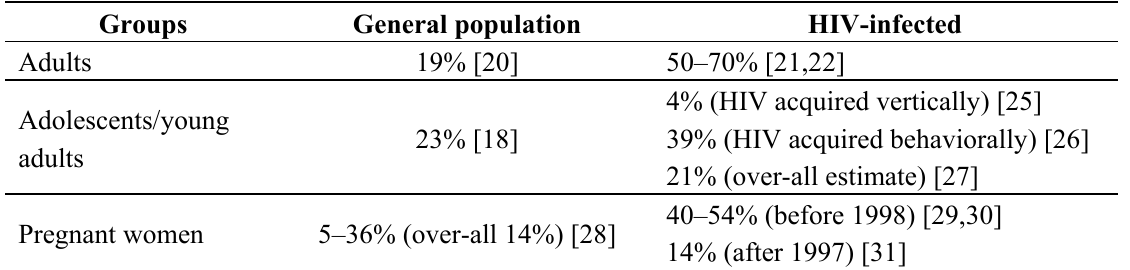
Table 1. A comparison of the prevalence of tobacco use between HIV-infected and general